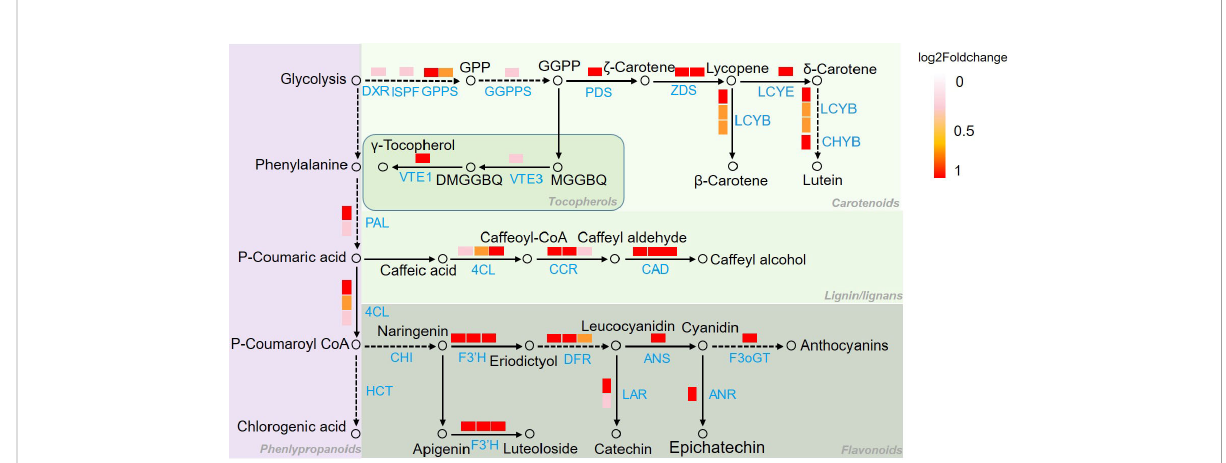
FIGURE 7 Pathway mapping of secondary metabolism related DEGs in Figure 5. Genes identi fi cation and expression were represented by boxes with different color. Metabolites were represented by hollow circles. 4CL, 4-coumarate: CoA ligase; ANR, anthocyanidin reductase; ANS, anthocyanidin synthase; CAD, cinnamol dehydrogenase; CCR, cinnamoyl CoA reductase; CHS, chalcone synthase; LCYB, lycopene beta cyclase; LCYE, lycopene epsilon cyclase; CHYB, b -carotene hydroxylase, F3 ’ H, fl avonoid 3 ’ -hydroxylase; DFR, dihydro fl avonol 4-reductase, DXR, 1- deoxy-D-xylulose 5-phosphate reductase; F3oGT, fl avonol-3-O-glucosyl transferase; GGPPS, geranylgeranyl pyrophosphate synthase; GPPS, geranyl pyrophosphate synthase; ISPF, 2C-methyl-d-erythritol 2,4-cyclodiphosphate synthase; LAR, leucoanthocyantin reducase, PAL, phenylalanine ammonia lyase; PDS, phytoene desaturase; VTE1, tocopherol cyclase; VTE3, 2-methyl-6-phytyl-1,4-benzoquinol methyltransferase; ZDS, z -carotene dehydrogenase; DXP, 1-deoxy-D-xylulose 5-phosphate; MEcPP, 2-C-methyl-d-erythritol-2,4-